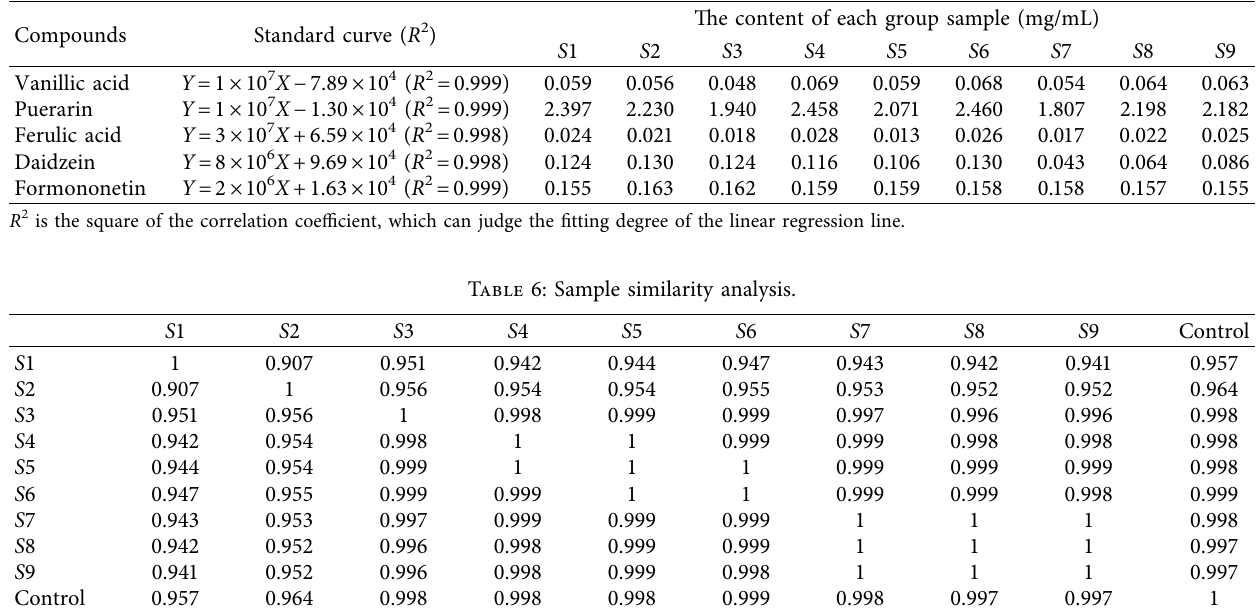
Table 5: The content of each group sample.